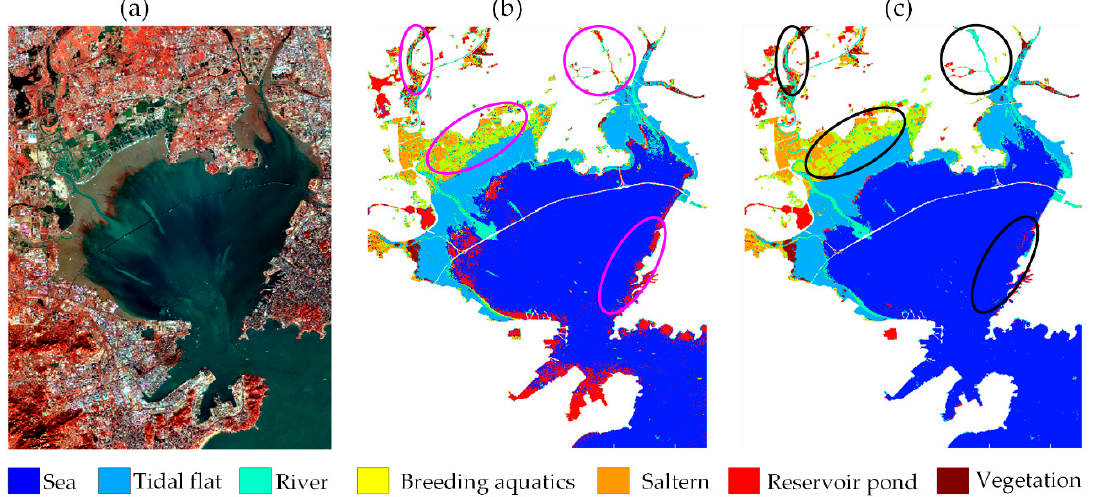
Figure 9. Classification results in Jiaozhou Bay wetland with ( a ) an image subset (NIR, G, and B bands only), ( b ) SCAA_MLP classification with spectral features, and ( c ) SCAA_MLP classification with spectral EMAP spatial features.